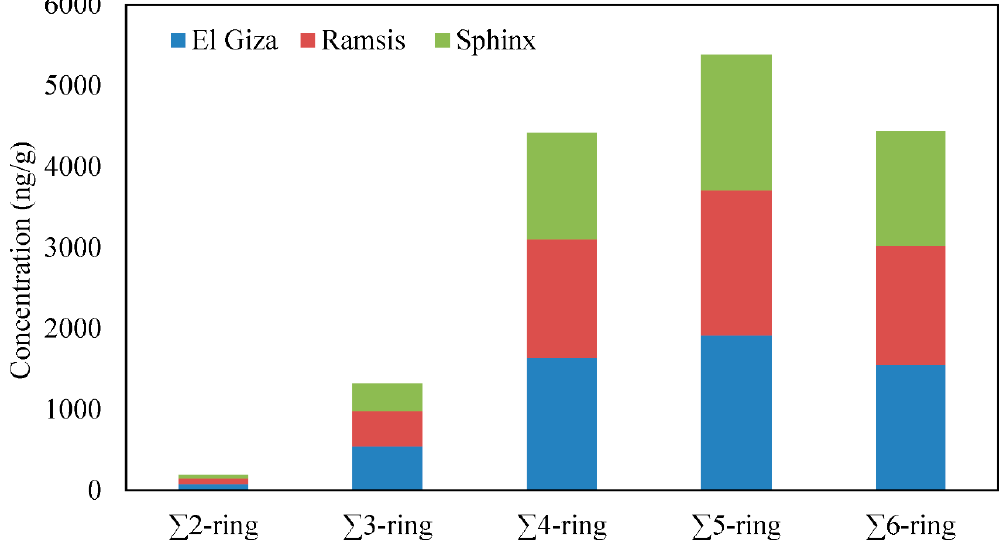
Figure 3. Comparison of the concentrations of PAH compound in total suspended particulate matter collected from El Giza, Ramsis, and Sphinx Square, based on aromatic ring number.